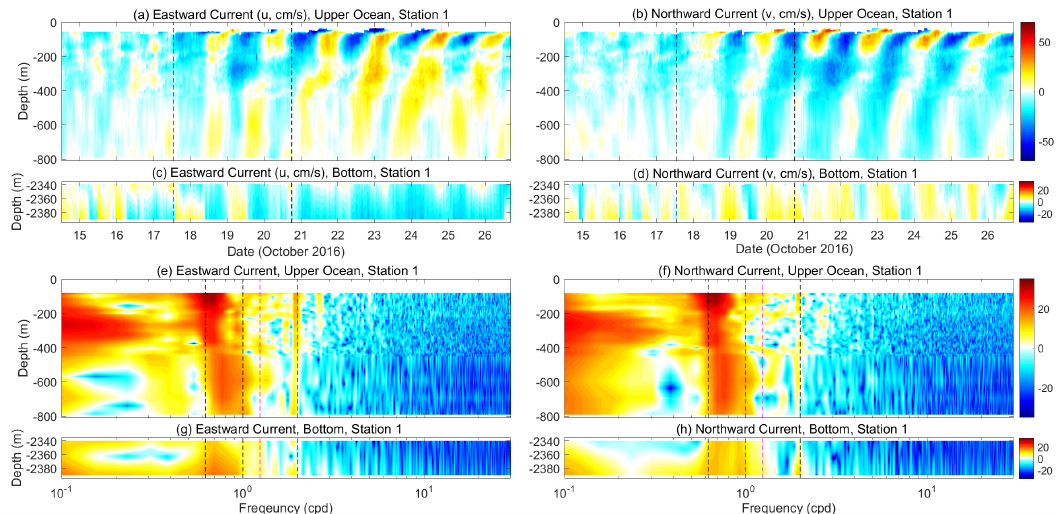
Figure A2. Eastward and northward current ( a – d ) at Station 1. Spectra of the eastward and northward currents at ( e – h ) Station 1 between October 13 and 26. The black dashed lines indicate the inertial, diurnal, and semidiurnal frequencies. The violet dashed lines indicate twice the inertial frequency.